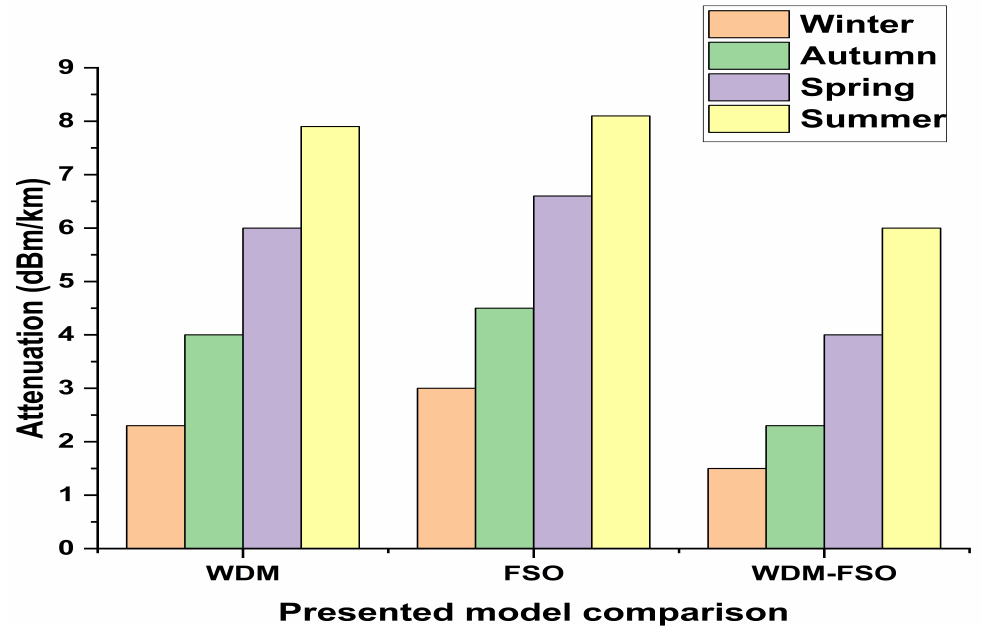
Figure 3. Comparison analysis of standard and presented models against attenuation in different weather